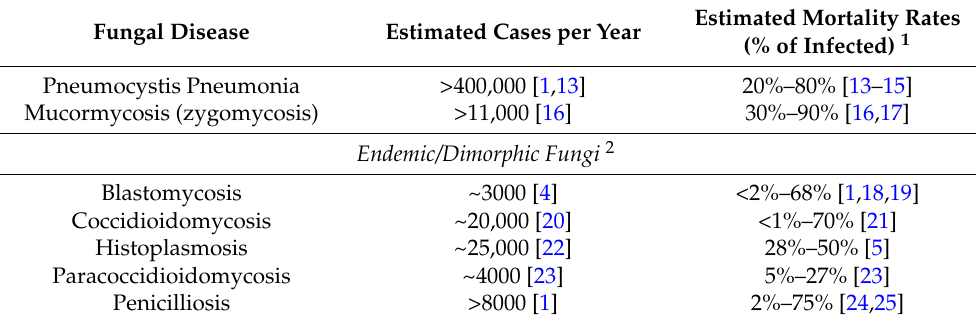
Table 2. Estimated yearly incidences of invasive fungal